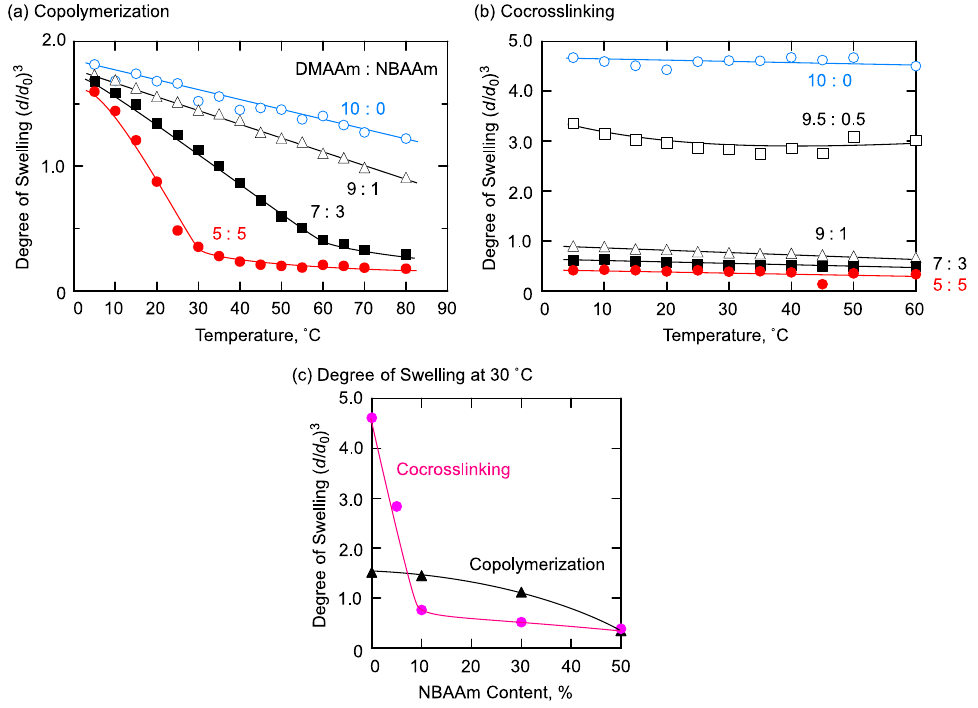
Figure 4. Swelling behavior of DMAAm/NBAAm ( a ) copolymerization and ( b ) co-crosslinking gels; ( c ) Relation between NBAAm content and the degree of swelling at 30 ◦ C. Preparation condition of copolymerization gels: [DMAAm] + [NBAAm] = 1400 mM, [BIS] = 48.6 mM, [AIBN] = 55.6 mM in methanol at 55 ◦ C. Preparation condition of co-crosslinking gels: [DMAAm unit] + [NBAAm unit] = 1400 mM, [NHSA unit] = [amino groups in EDA] in N , N -dimethylformamide (DMF) at room temperature.